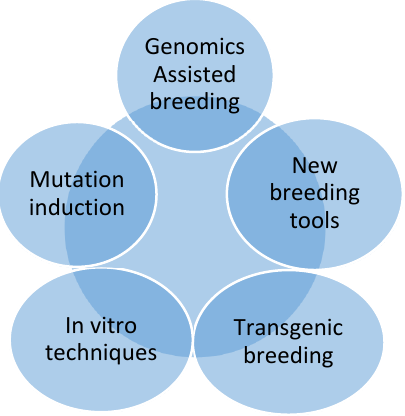
Figure 2. Key research areas for potential interest for fruit crops improvement.